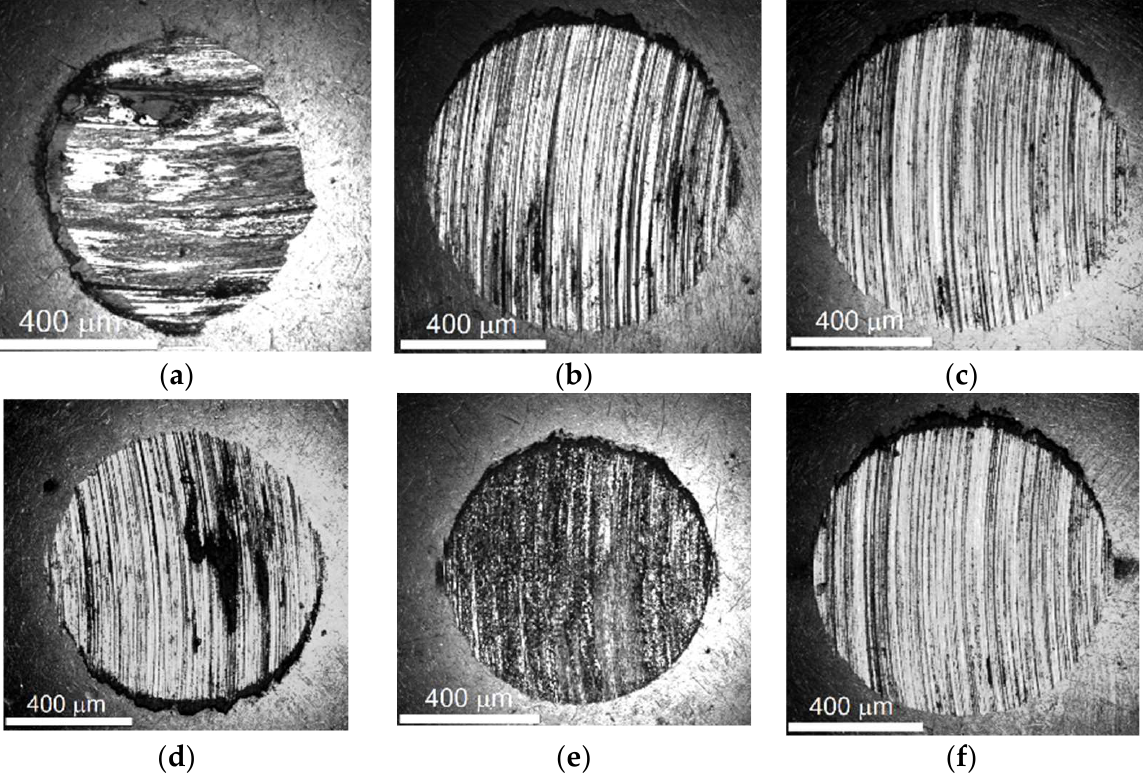
Figure 7. The wear scar images on steel balls rubbed against ZrN ( a ), CrN ( b ), ZrCrN(0.5) ( c ), ZrCrN(3.5) ( d ), ZrCrN(5) ( e ) and ZrCrN(8) ( f ) samples at 1 Н.